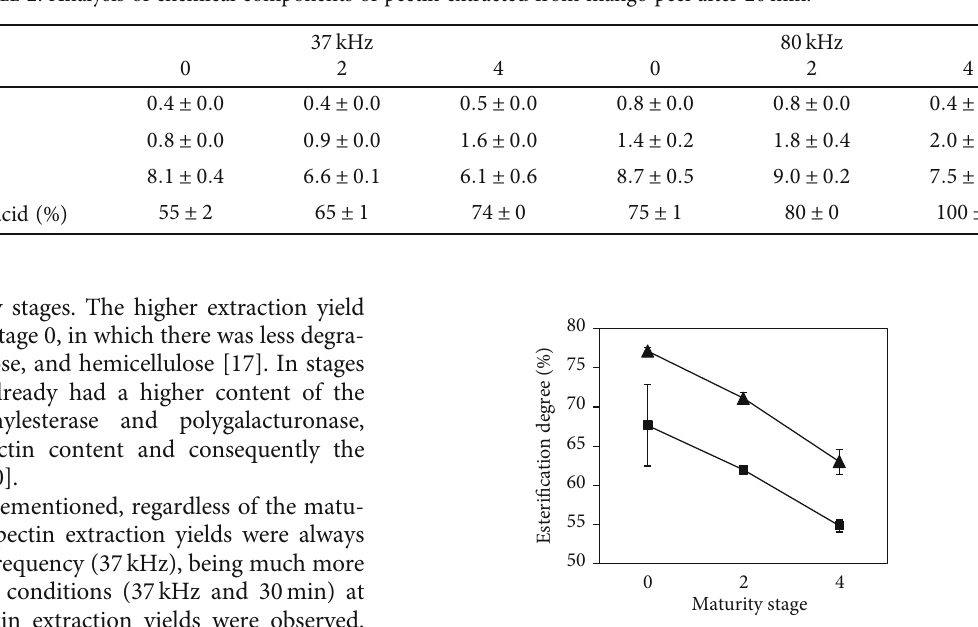
Table 2: Analysis of chemical components of pectin extracted from mango peel after 20min.